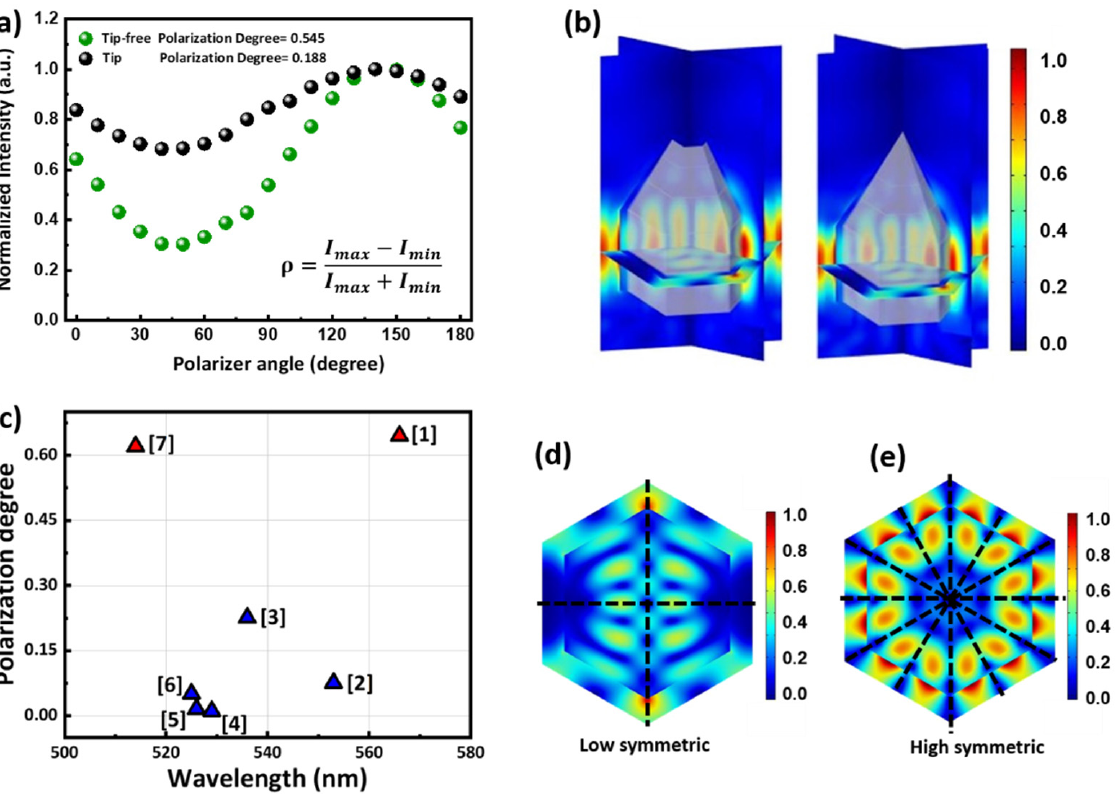
Figure 3. ( a ) Polarization measurement result of tip and tip-free core–shell nanorod LED and ( b ) simulated mode profile in the tip and tip-free structure; ( c ) polarization enhances trend between different fundamental modes; ( d , e ) low symmetric mode profile and high symmetric mode profile.